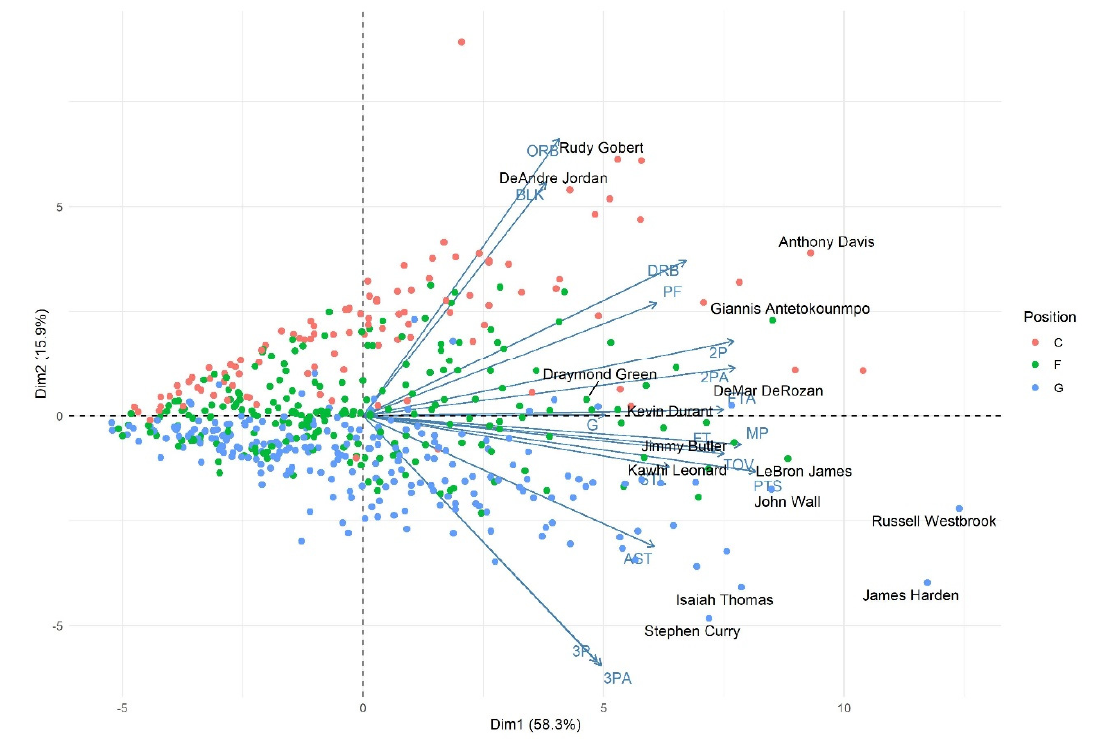
Figure A4 . Principal Component Analysis of active players in the 2016–17 NBA Season.